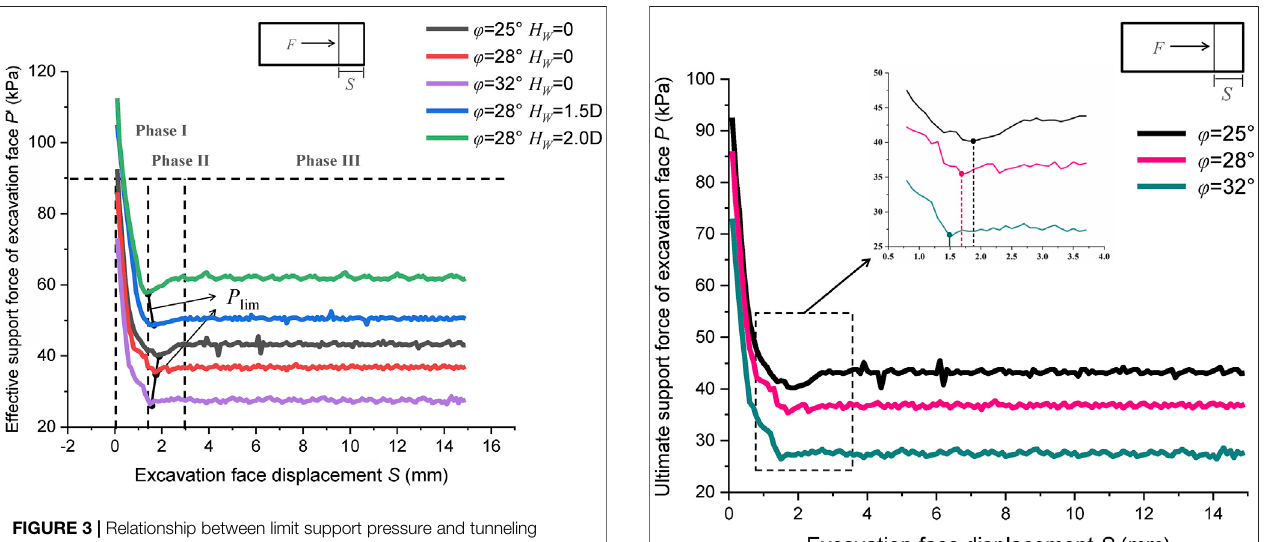
FIGURE 3 | Relationship between limit support pressure and tunneling face displacement.